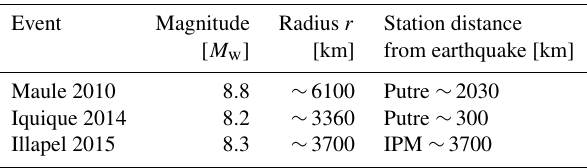
Table 2. The maximum radius where the ionosphere–lithosphere– atmosphere coupling may affect magnetic measurements corre- sponding to each earthquake studied at the stations of Putre and IPM (Dobrovolsky et al., 1979; Pulinets and Boyarchuk, 2004). The preparation area or Dobrovolsky area is defined by the ra- dius r = 10 0 . 43 M , where M is the earthquake magnitude. This table shows that the Putre and IPM stations are within the earthquake preparation stage for Maule, Iquique, and Illapel. Event Magnitude Radius r Station distance [ M w ] [km] from earthquake